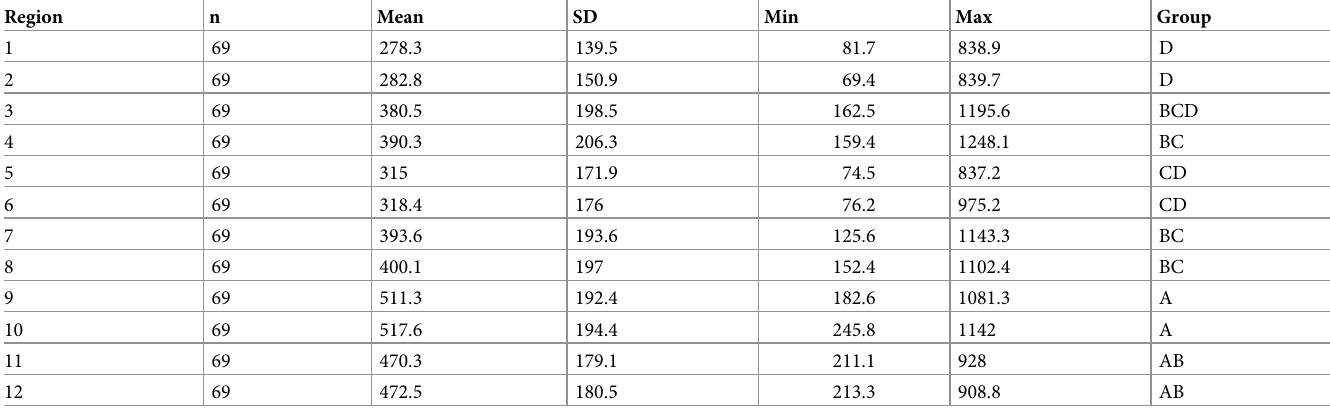
cervical spines might be similar. Our data also indicate that the female cervical vertebrae are smaller than male vertebrae (Fig 4). Accordingly, the magnitude of the mechanical stress act- ing on female cervical vertebrae is greater and requires higher bone strength, which is posi- tively related to bone density [26,27]. This could possibly explain why our average female specimen BMD values were higher than those from males. Table 3. Descriptive statistics of BMD in C3-5. Values of BMD are reported in terms of mg/cm 3 .